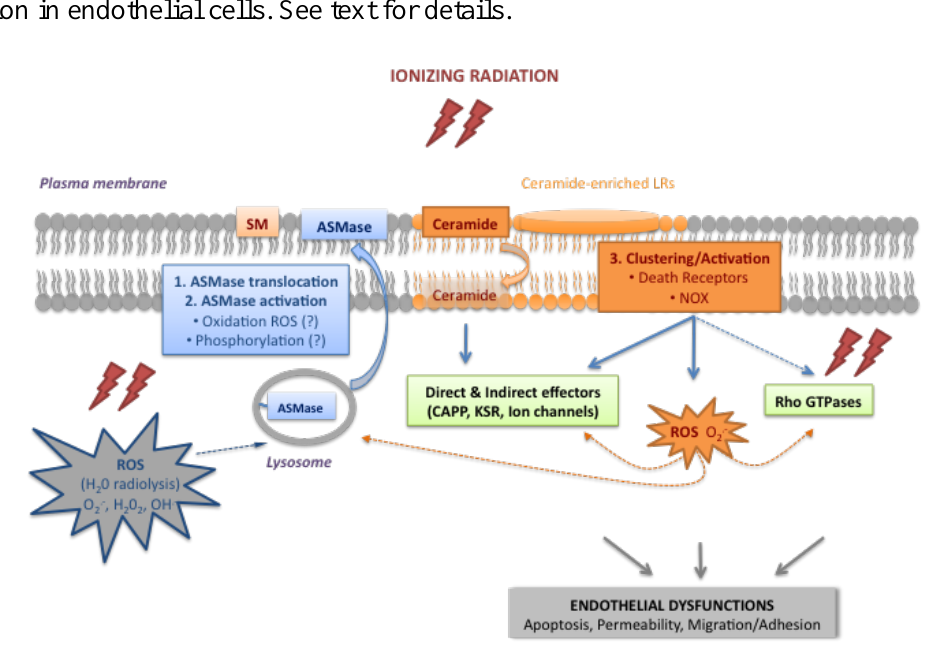
Figure 3. Diagram of the plasma membrane signaling pathways induced by ionizing radiation in endothelial cells. See text for